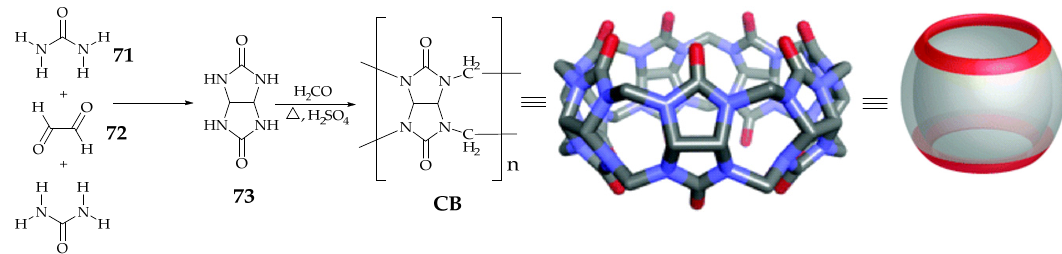
Scheme 8. General scheme for the synthesis of cucurbituril (CB).